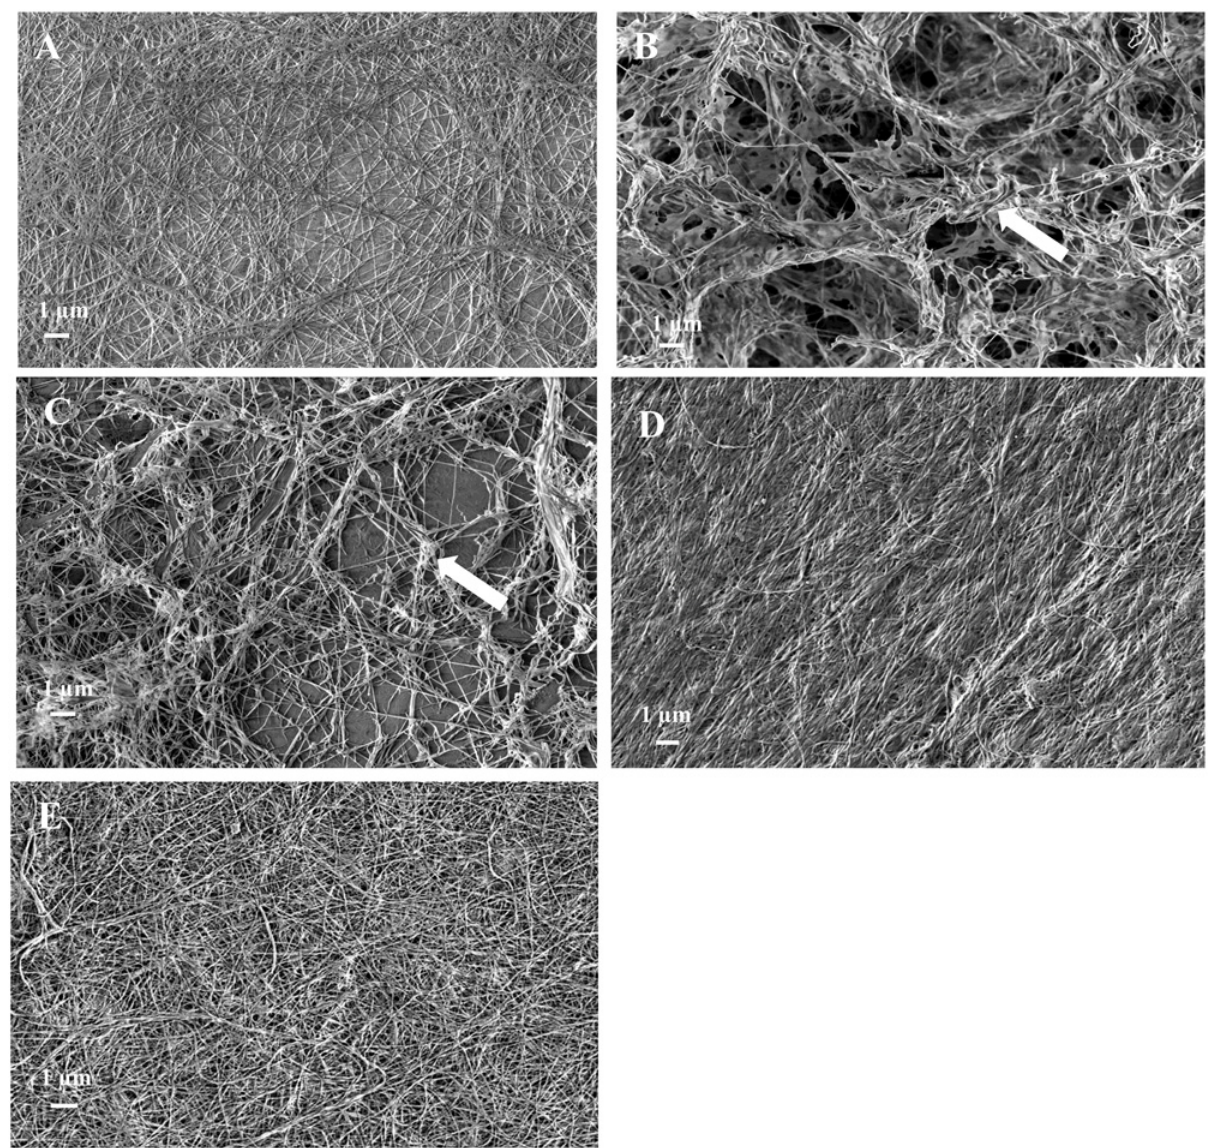
CE ; E). White arrows in (B) and (C) point to a region of cellulose pellicles produced by mutant I-23 and mutant #52 where non- cellulosic polysaccharides may be